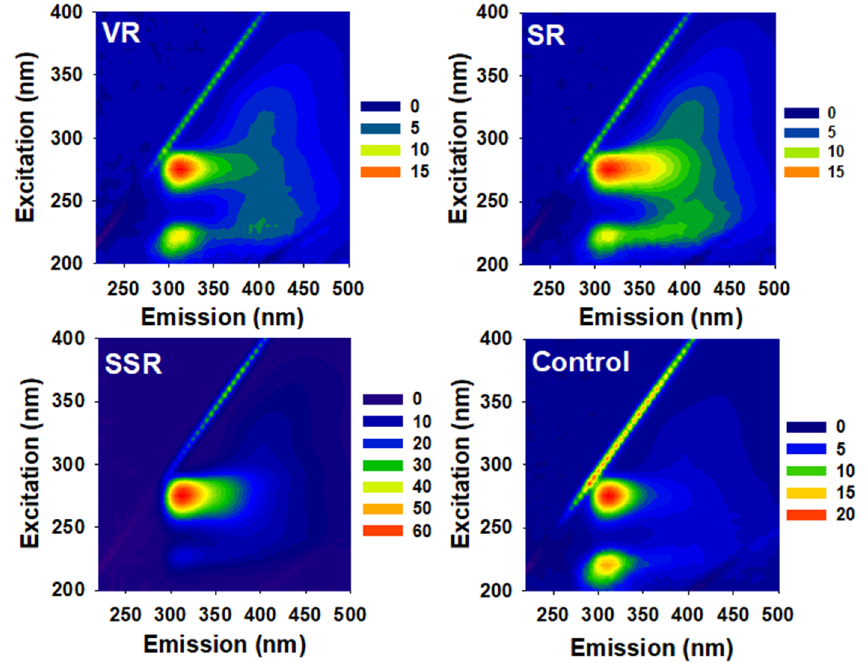
Figure 3. EEM fluorescence spectra of DOM obtained from the co-digesting PWs and WAS on day 4.